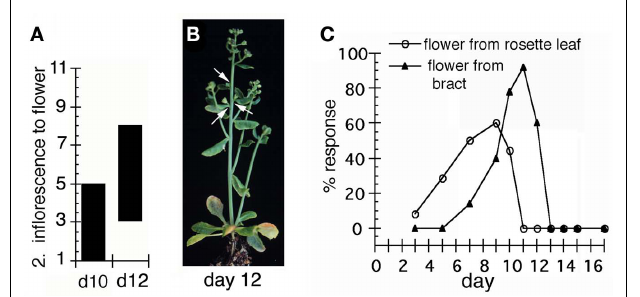
FIGURE 1 |Transient LFY activation in lfy-6 35S:LFY-GR. Seedlings were treated with 5 μ M dexamethasone for 2h. (A) Effect of treatment at different days after germination.The y -axis indicates the positions (from basal to apical) of the secondary inflorescences converted to flowers. (B) A mature lfy-6 LFY-GR plant.The arrows indicate three secondary inflorescences, which were converted into flowers. Note that above and below these flowers secondary inflorescences were formed. All flowers were subtended by bracts, suggesting they retained partial inflorescence identity. Mock-treated inflorescences and seedlings as well as dexamethasone treated plants not expressing the LFY-GR fusion protein were indistinguishable from untreated siblings (data not shown). (C) The ratio of plants exhibiting a given response over the total number of plants per treatment day (% response) was determined. For each treatment day 20–30 plants were scored after bolting. lfy-6 35S:LFY-GR plants were assayed for conversion of axillary inflorescences to flowers ( ) and for conversion of secondary inflorescences to flowers (